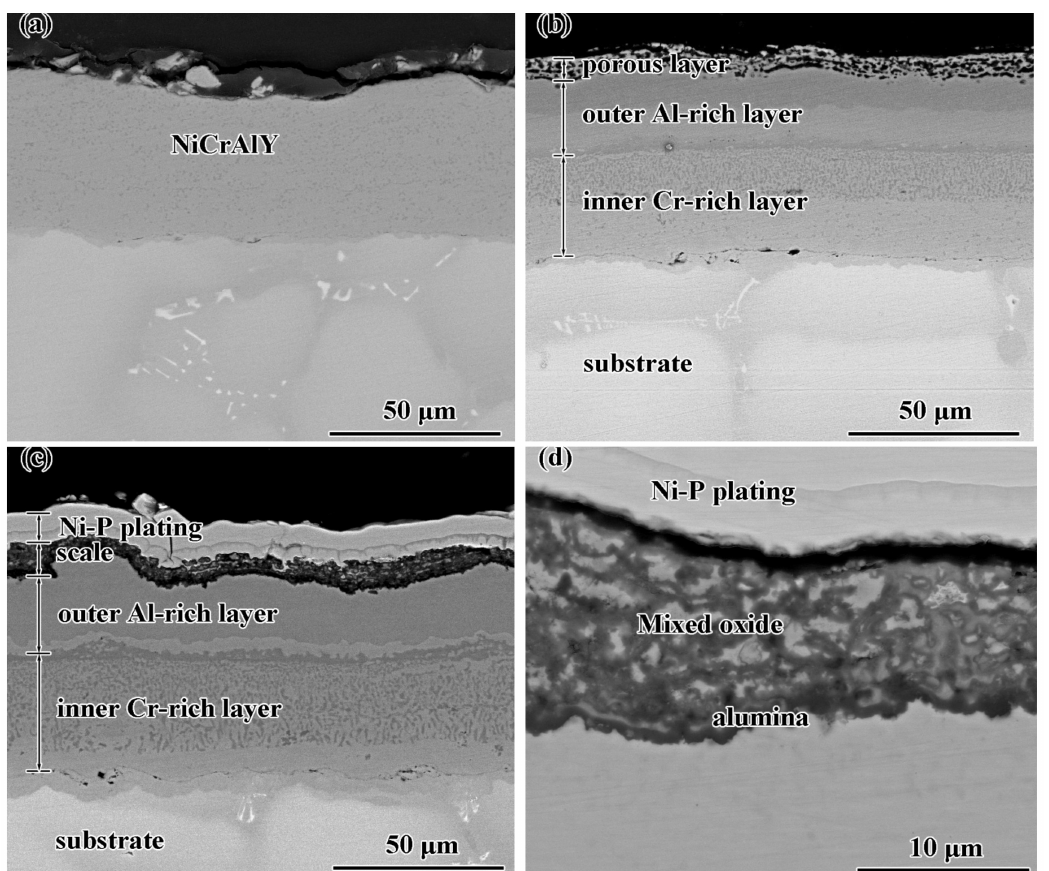
Figure 2. Cross-sectional BSE images of the coatings in the as-received state: ( a ) the conventional coating; ( b ) the gradient coating; ( c ) the preoxidised coating; ( d ) the preoxidised coating (high